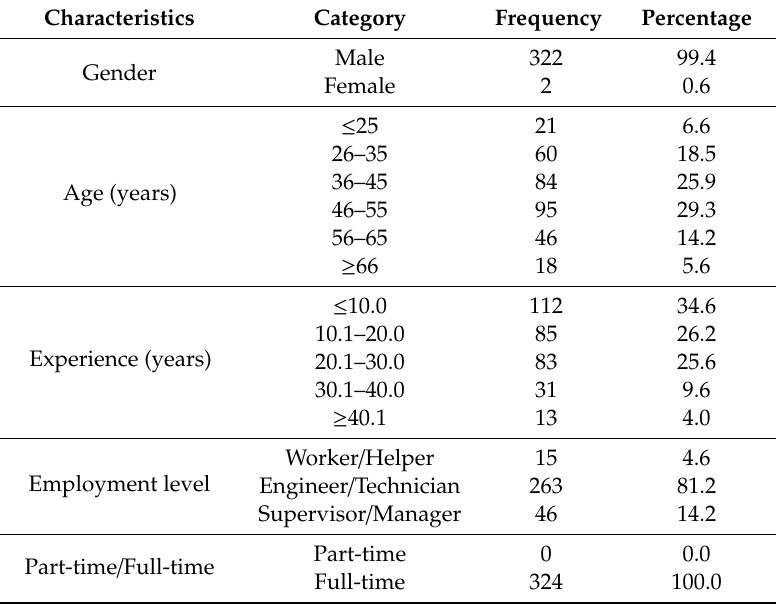
Table 3. Participant demographics ( N =